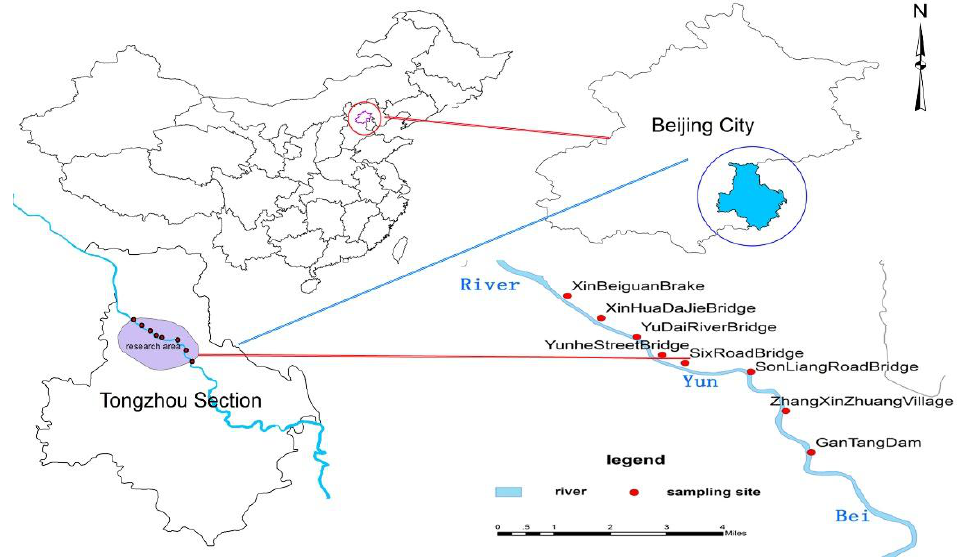
Figure 1. Map of the study area and surface water sampling sites in the Tongzhou Section of the Beiyun River (TSBR).